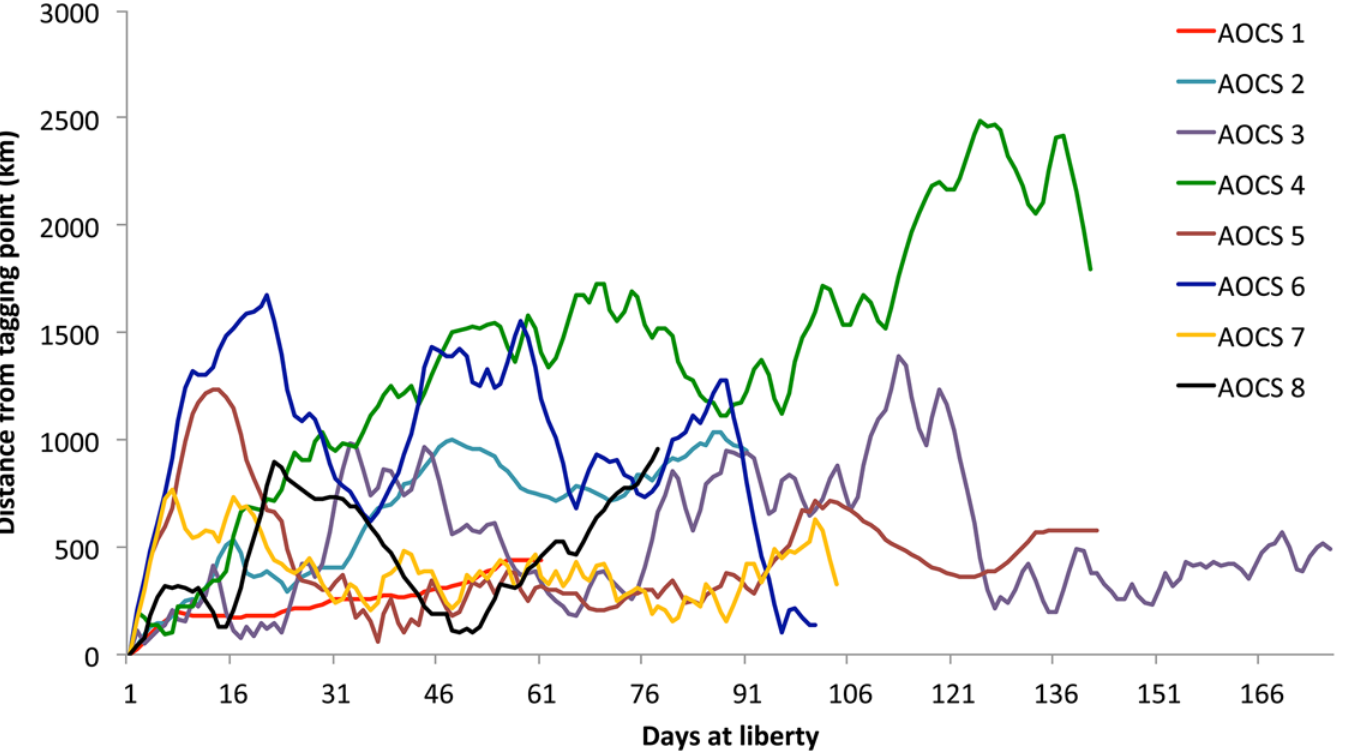
Fig 3. Distance from the tagging position as a function of days at liberty for oceanic whitetip sharks tagged in the western Atlantic Ocean between 2010 and 2012.